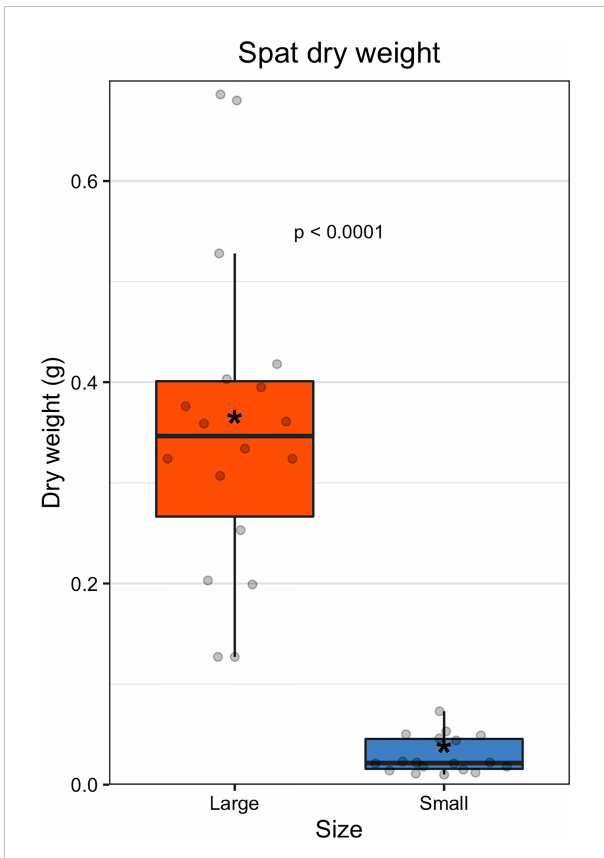
FIGURE 1 Dry weight of spat by size class. The colored boxes represent upper and lower quartiles, horizontal lines in boxes show the median values, and the vertical whiskers represent the most extreme values within the 1.5x interquartile range. Asterisks display mean values.